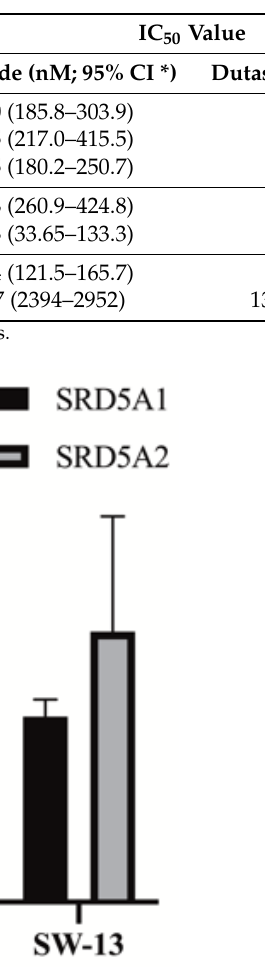
Figure 2. Quantitative PCR analysis for measuring the mRNA expression levels of SRD5A1 and SRD5A2 in the LNCaP, DU-145, and SW-13 cell lines. The data are expressed as the mean ± standard deviation (SD) of three repeated experiments.